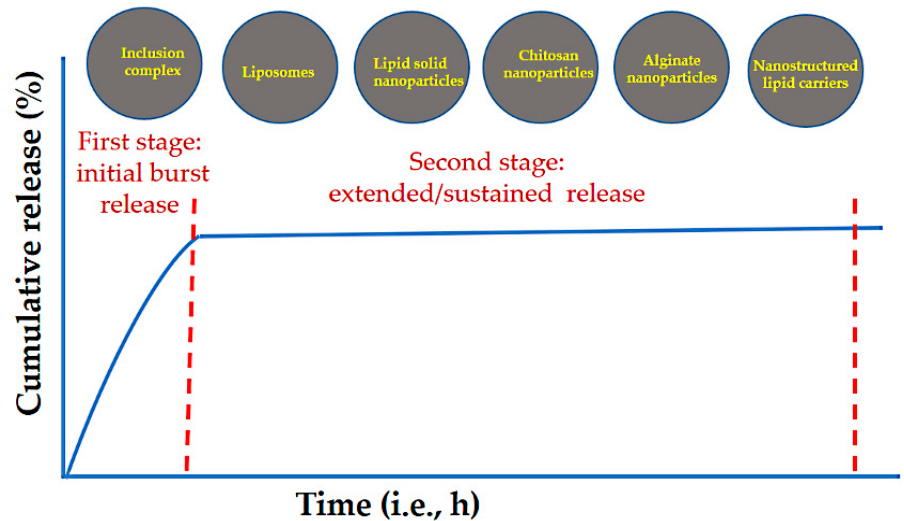
Figure 9. Schematic representation of the two-stage release pattern for EOs from various nanostruc- tures, such as polymers, lipids, and inclusion complexes. As indicated in the literature, this release profile for EOs is the most common.